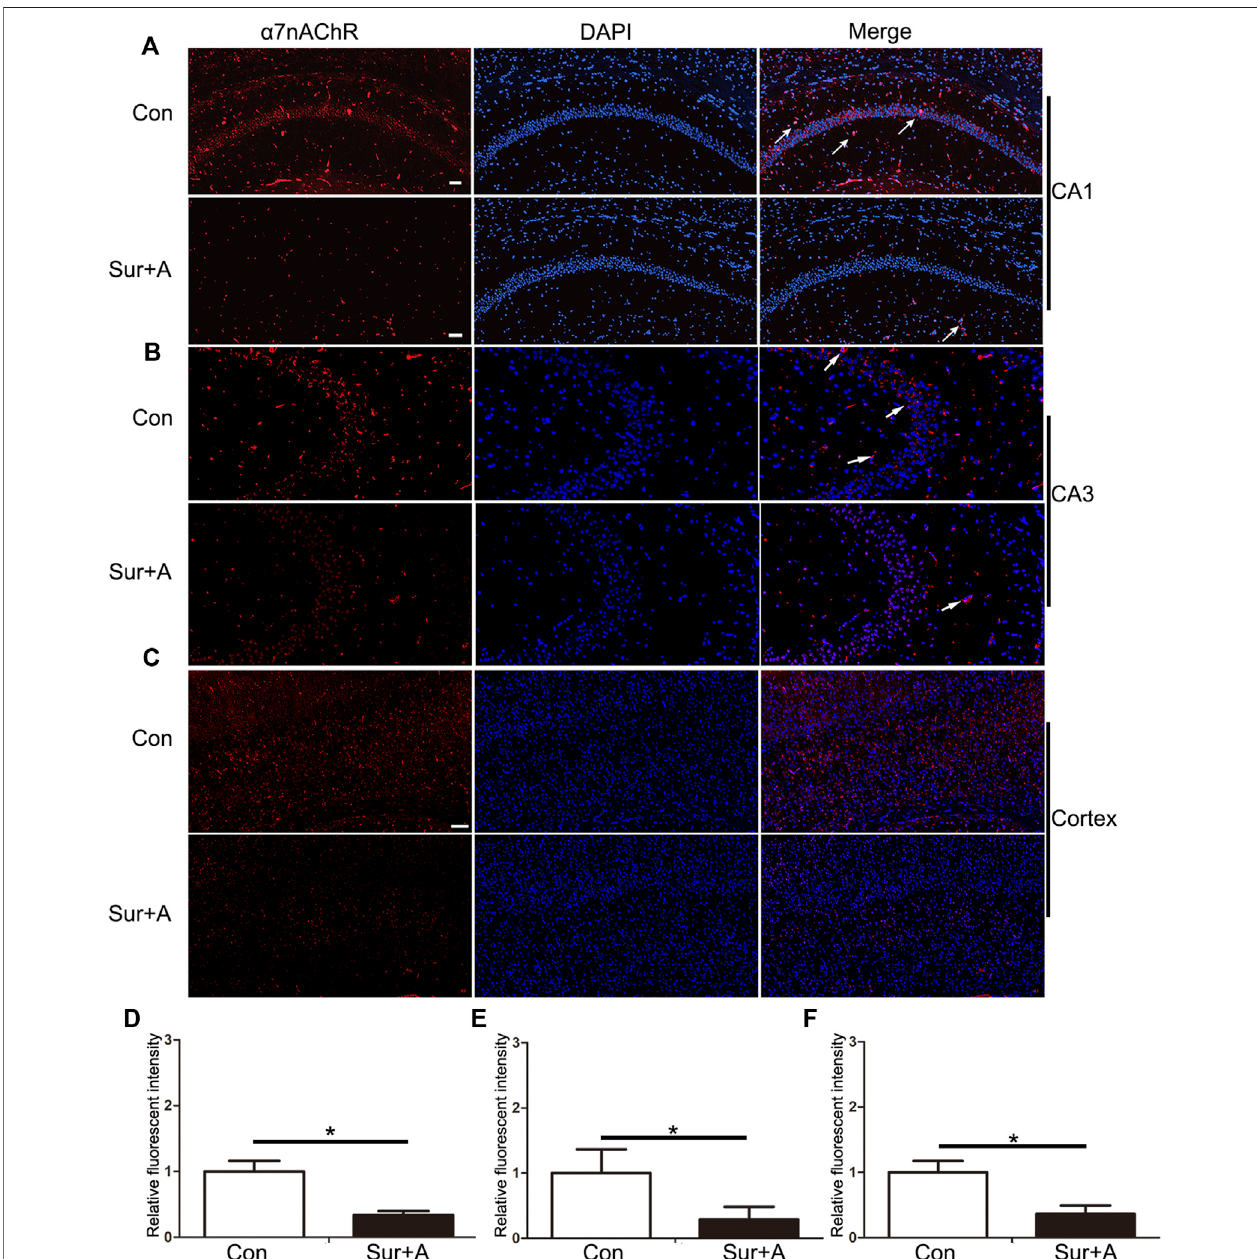
FIGURE 2 | Effects of surgery and anesthesia on α 7nAChR expression in the hippocampus and cortex in aged mice. Representative images of α 7nAChR positive cells (red) in the hippocampi of CA1 region (A) , CA3 region (B) , and cortex (C) , 24 h after surgery and anesthesia. Quanti fi cations of the relative fl uorescent intensity for α 7nAChR positivecellsin hippocampal CA1region (D) ,and CA3 region (E) , andcortex (F) . Dataarepresented asmean±SD. DAPIstainingisshown in blue. * p < 0.05. Scale bar for CA 1 = 50 μ m; Scale bar for cortex = 100 μ m. Con = Control; Sur+A, Surgery plus Anesthesia.